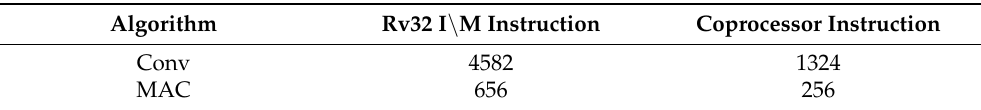
Table 4. Number of instructions required by different arithmetic units to run under different instruc- tion